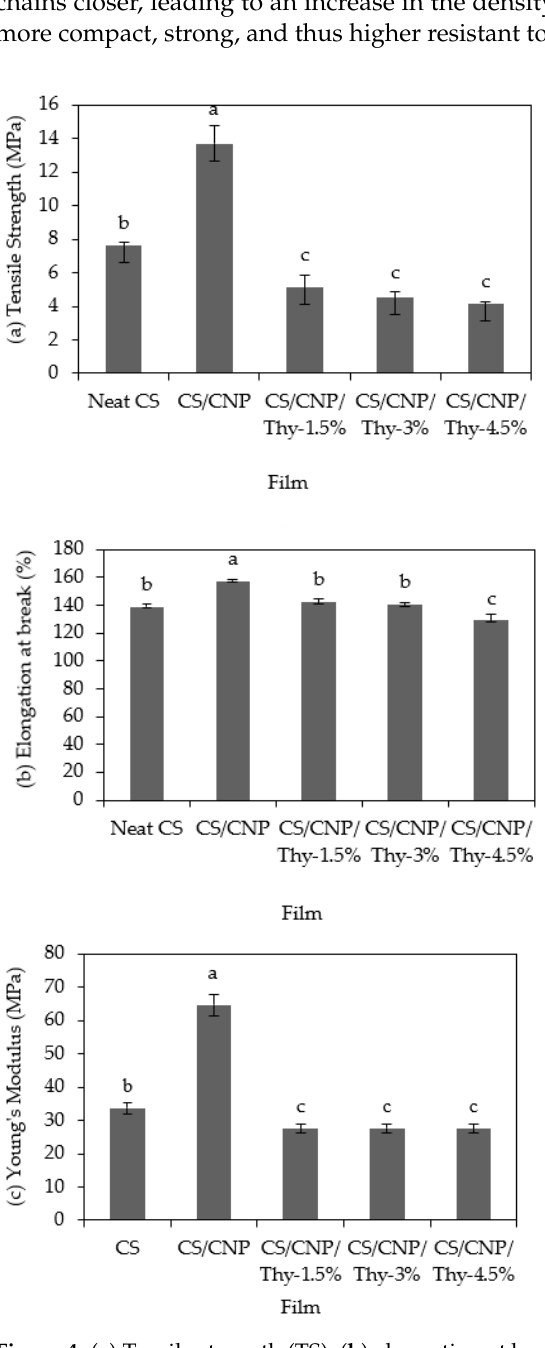
Figure 4. ( a ) Tensile strength (TS); ( b ) elongation at break (EAB); ( c ) Young’s modulus (YM) of